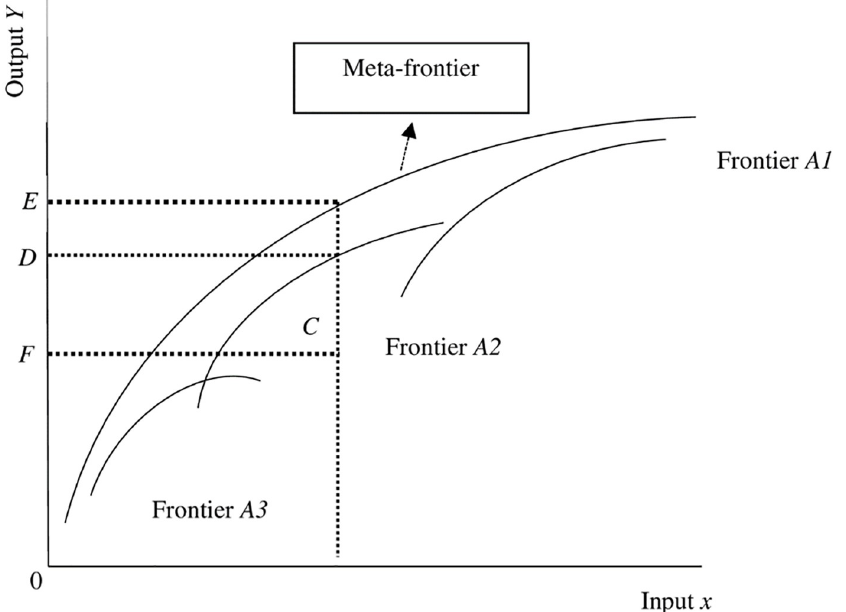
Fig 3. Efficiency analysis based on meta-frontier